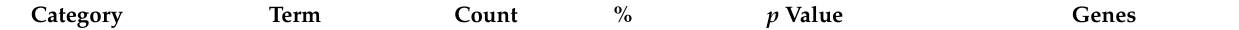
Table 6. Top three GO terms significantly enriched in DEGs related to anti-apoptosis in NK-5962-treated retinas (DAVID). Category